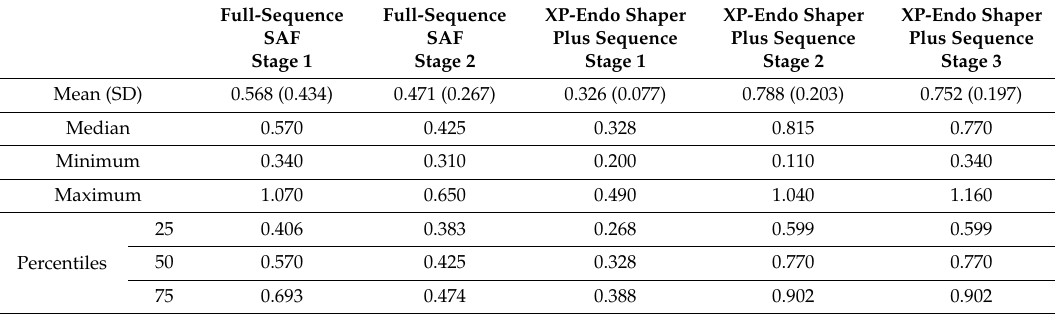
Table 1. Weight of apically extruded debris (mg). Data